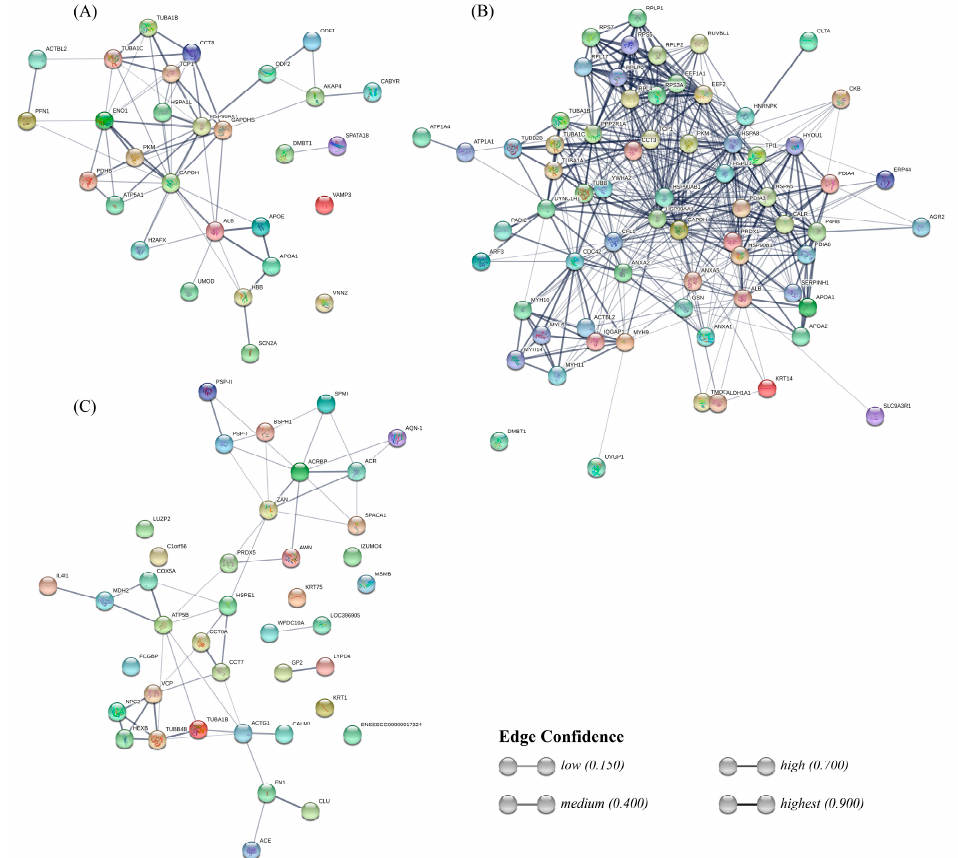
Figure 5. STRING network showing the interactions between uterine fluid (UF) sperm-interacting proteins ( A ), oviductal fluid (OF) sperm-interacting proteins ( B ), and seminal plasma (SP) sperm-interacting proteins ( C ).